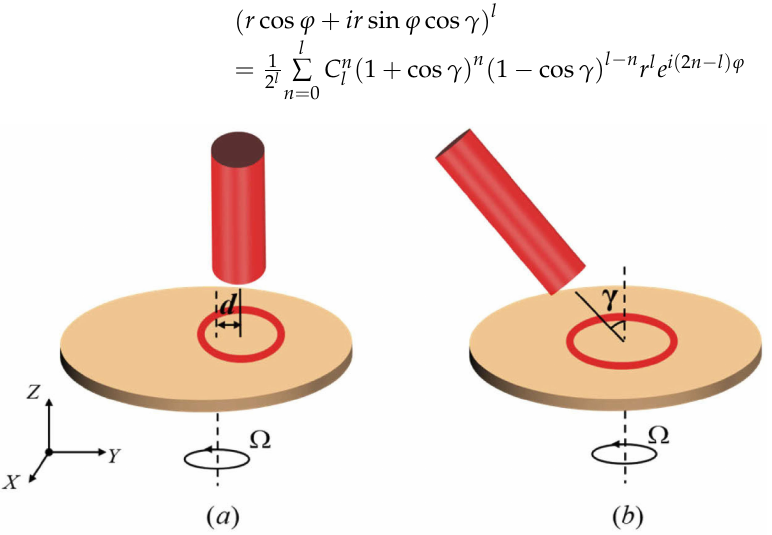
Figure 18. ( a ) Lateral misalignment of a light spot on a rotating surface. ( b ) Incident on the rotating surface at a certain angle. Adapted with permission from ref.